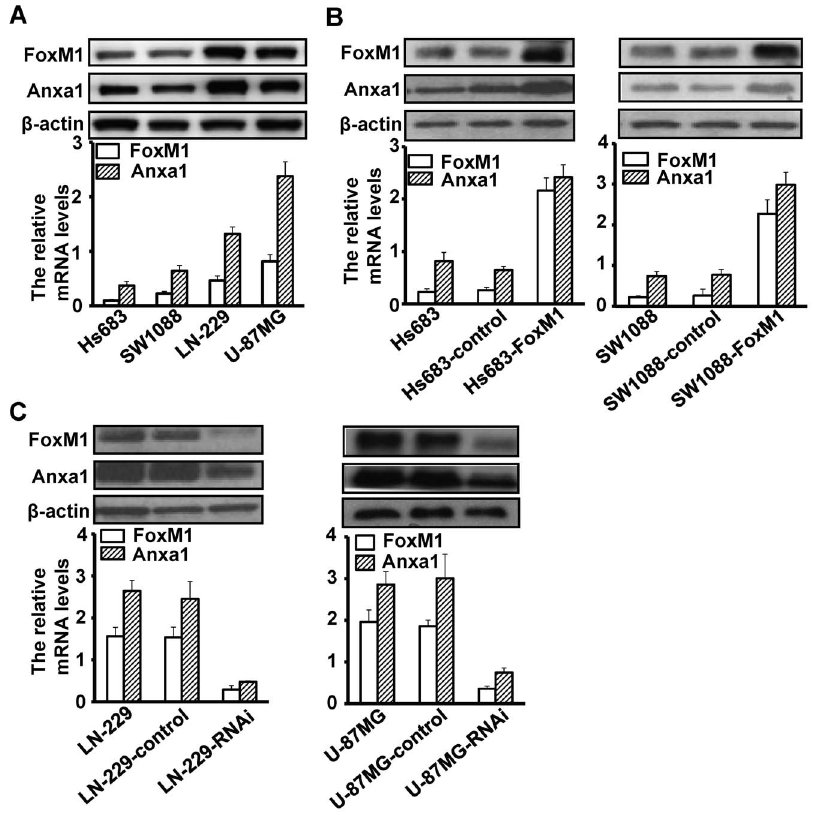
Figure 2. Effects of altered FoxM1 expression on Anxa1 expression in human glioma cell lines. A, Determination of FoxM1 and Anxa1 expression in human glioma cell lines using RT-qPCR (lower) and Western blot (upper). B, Up-regulation of Anxa1 mRNA and protein expression by overexpressing FoxM1. FoxM1 and Anxa1 expression levels in parental, control, and Hs683-FoxM1 and SW1088-FoxM1 cells by RT-qPCR (lower) and Western blot (upper). C, Down-regulation of Anxa1 mRNA and protein expression by depletion of FoxM1 expression. FoxM1 and Anxa1 expression in parental, control, and LN-229-RNAi and U-87MG-RNAi cells by RT-qPCR (lower) and Western blot (upper).